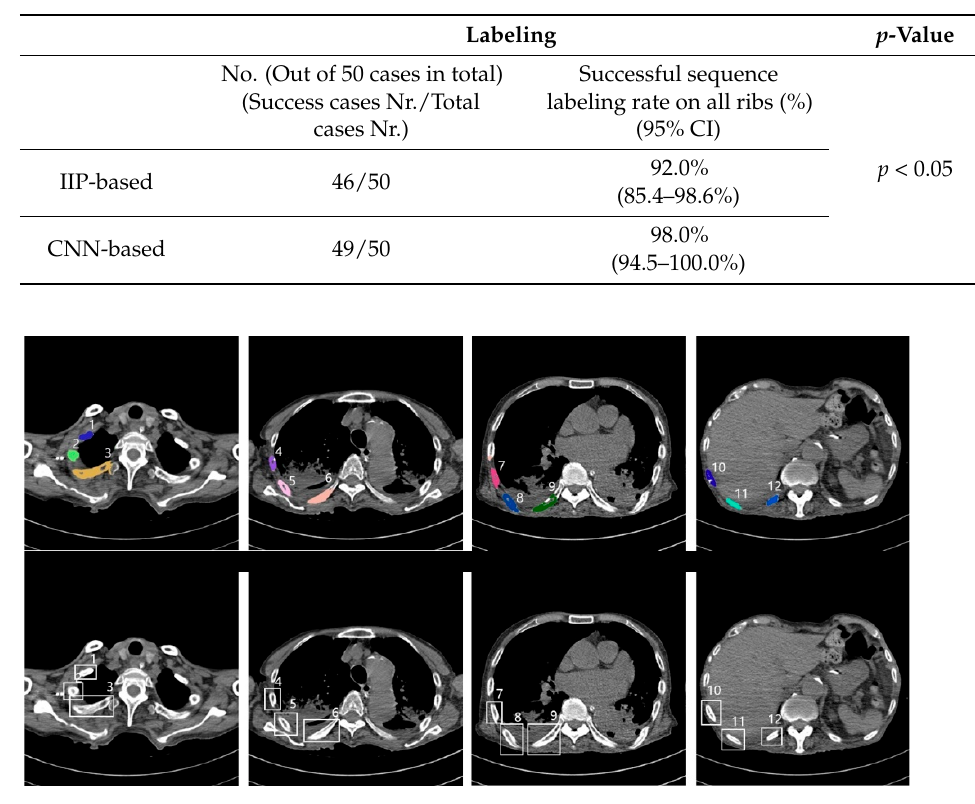
Figure 5. Results of sequence labeling; annotation for sequence labels with coloring ( top ) and boxes ( bottom ), including nearby numbers (1–12) labels indicating the order of the ribs from the top of the upper body (CNN, convolutional neural network).